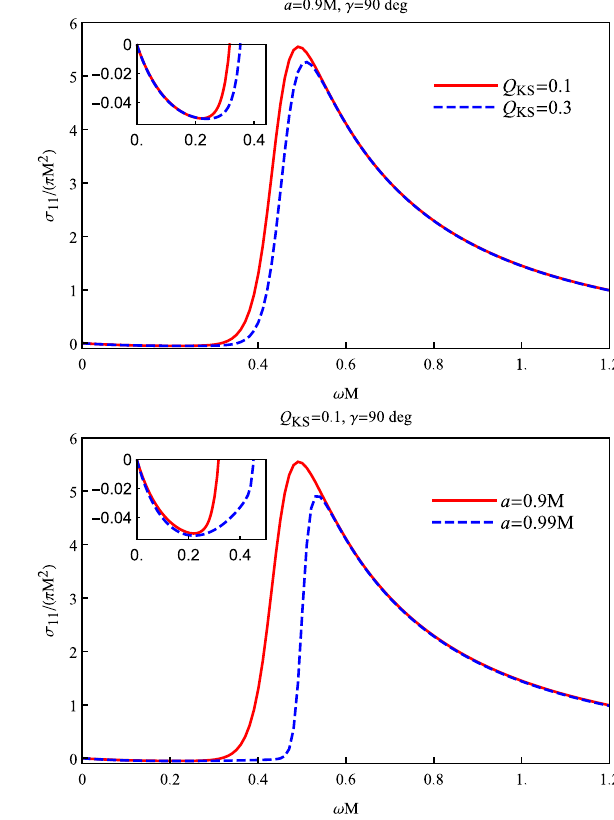
Fig. 4 Total absorption cross section for different values of the rota- tion parameter (top) and electric charge (bottom), plotted for equatorial incidence